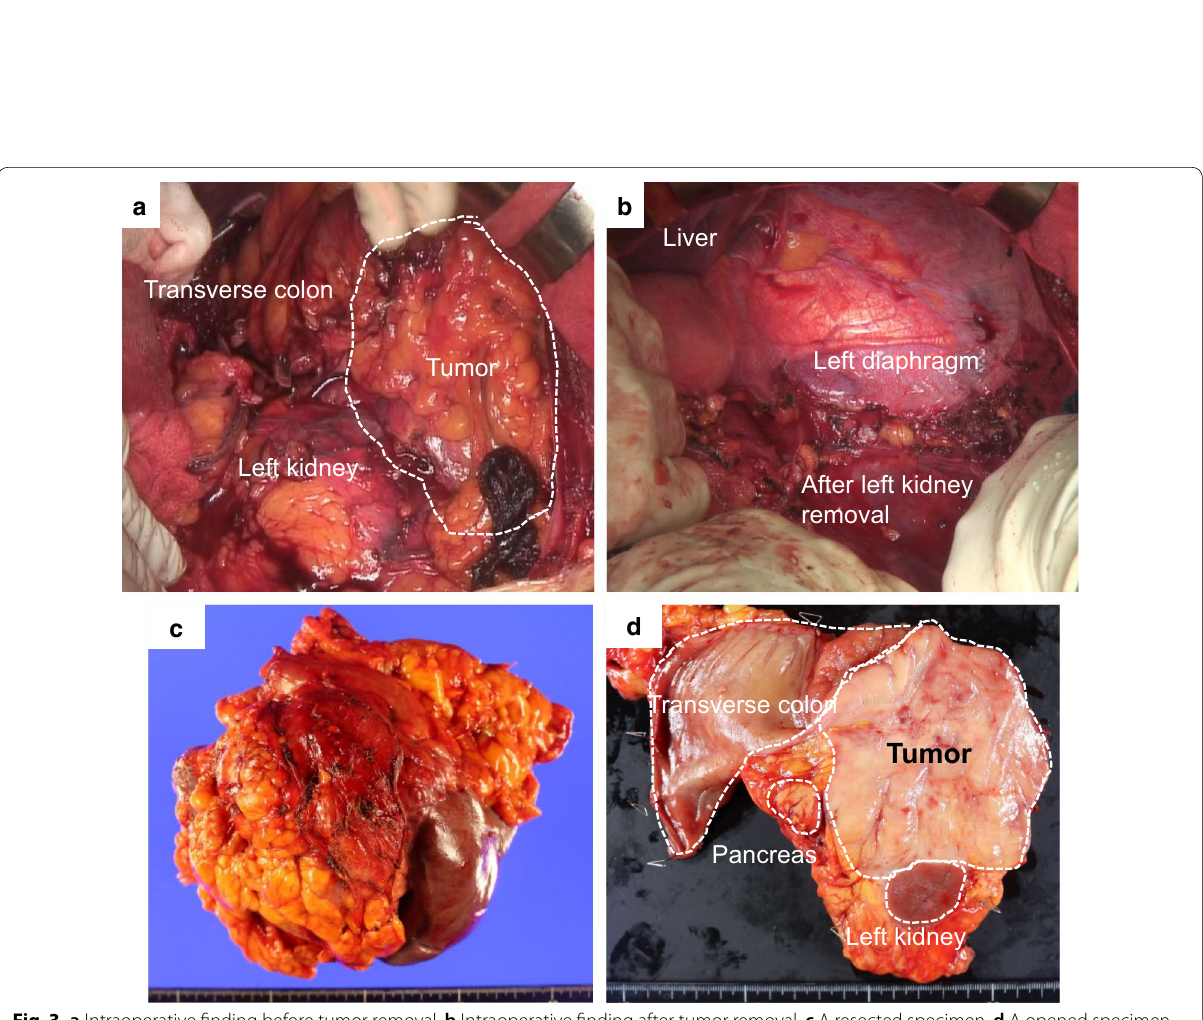
Fig. 3 a Intraoperative finding before tumor removal. b Intraoperative finding after tumor removal. c A resected specimen. d A opened